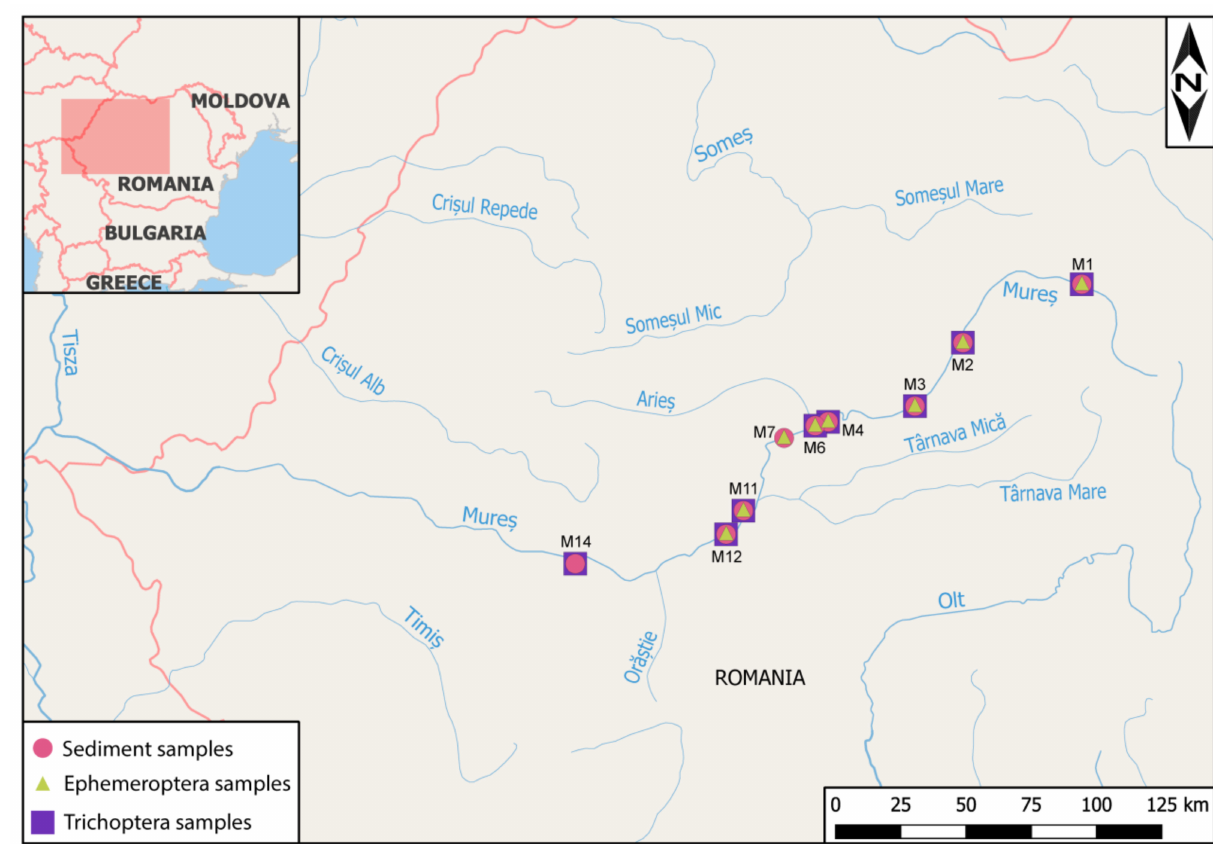
Figure 1. The sample sites with geographical coordinates are: M1 (46 94567–025 29396), M2 (46 73324–024 70280), M3 (46 50931–024 47209), M4 (46 44489–024 04081), M6 (46 42958–023 97672), M7 (46 38317–023 82367), M11 (46 38317–023 82367), M12 (46 04262–023 55594), M14 (45 91626–022